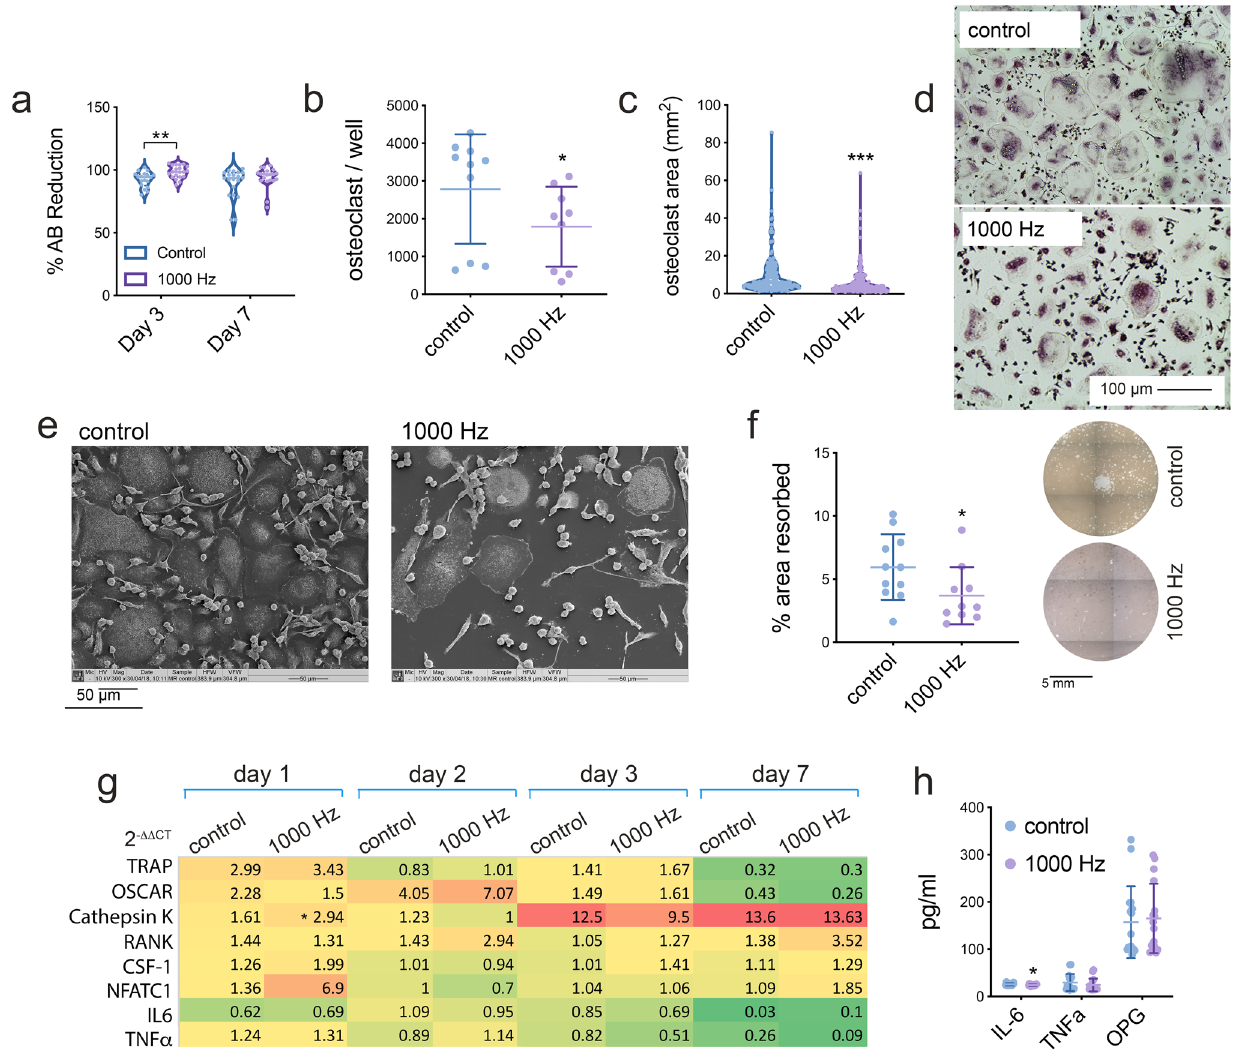
Figure 2. Osteoclast response to nanovibrational stimulation in 2D. ( a ) No detrimental effect on CD14 + cell viability was seen, as measured by Alamar blue (violin plots of individual data points, n = (d = 3, r = 3), statistics by t-test where *p < 0.05). However, ( b ) following 7 days of nanovibrational stimulation numbers of fused, multinucleate osteoclasts observed by TRAP staining were reduced (mean ± SD of individual data points, n = (d = 3, r = 3), statistics by t-test where *p < 0.05). Similarly, the mean osteoclast area ( c ) was also reduced with nanovibrational stimulation (violin plots of individual data points, n = (d = 3, r = 3), statistics by t-test where ***p < 0.001) after 7 days of culture; ( d ) typical TRAP staining of both control and 1000 Hz stimulated samples imaged at 10 × magnification. ( e ) SEM images at day 7 showing less osteoclasts were present following nanovibrational stimulation. (f) Resorption assay at day 7 showing less osteoclast activity following nanovibrational stimulation (mean ± SD of individual data points, n = (d = 3, r = 3), statistics by t-test where *p < 0.05). ( g ) qPCR for nanovibrated vs control CD14 + cells for transcripts related to osteoclastogenesis and inflammation. A trend towards repression of these genes in the nanovibrated cultures was observed (n = (d = 1–3, r = 3), statistics by t-test where *p < 0.05); full qPCR data is presented in Supplementary Fig. 2. ( h ) At the protein level, IL-6 was seen to be repressed (mean ± SD of individual data points, n = (d = 3, r = 4), statistics by t-test where *p < 0.05). Together, the data indicates a reduction in osteoclast forming activity of CD14 + blood mononuclear cells with nanovibrational